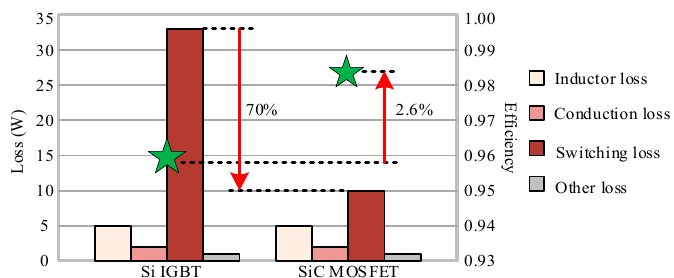
Figure 11. Loss and efficiency comparison of the rectifier with Si IGBT and SiC MOSFET